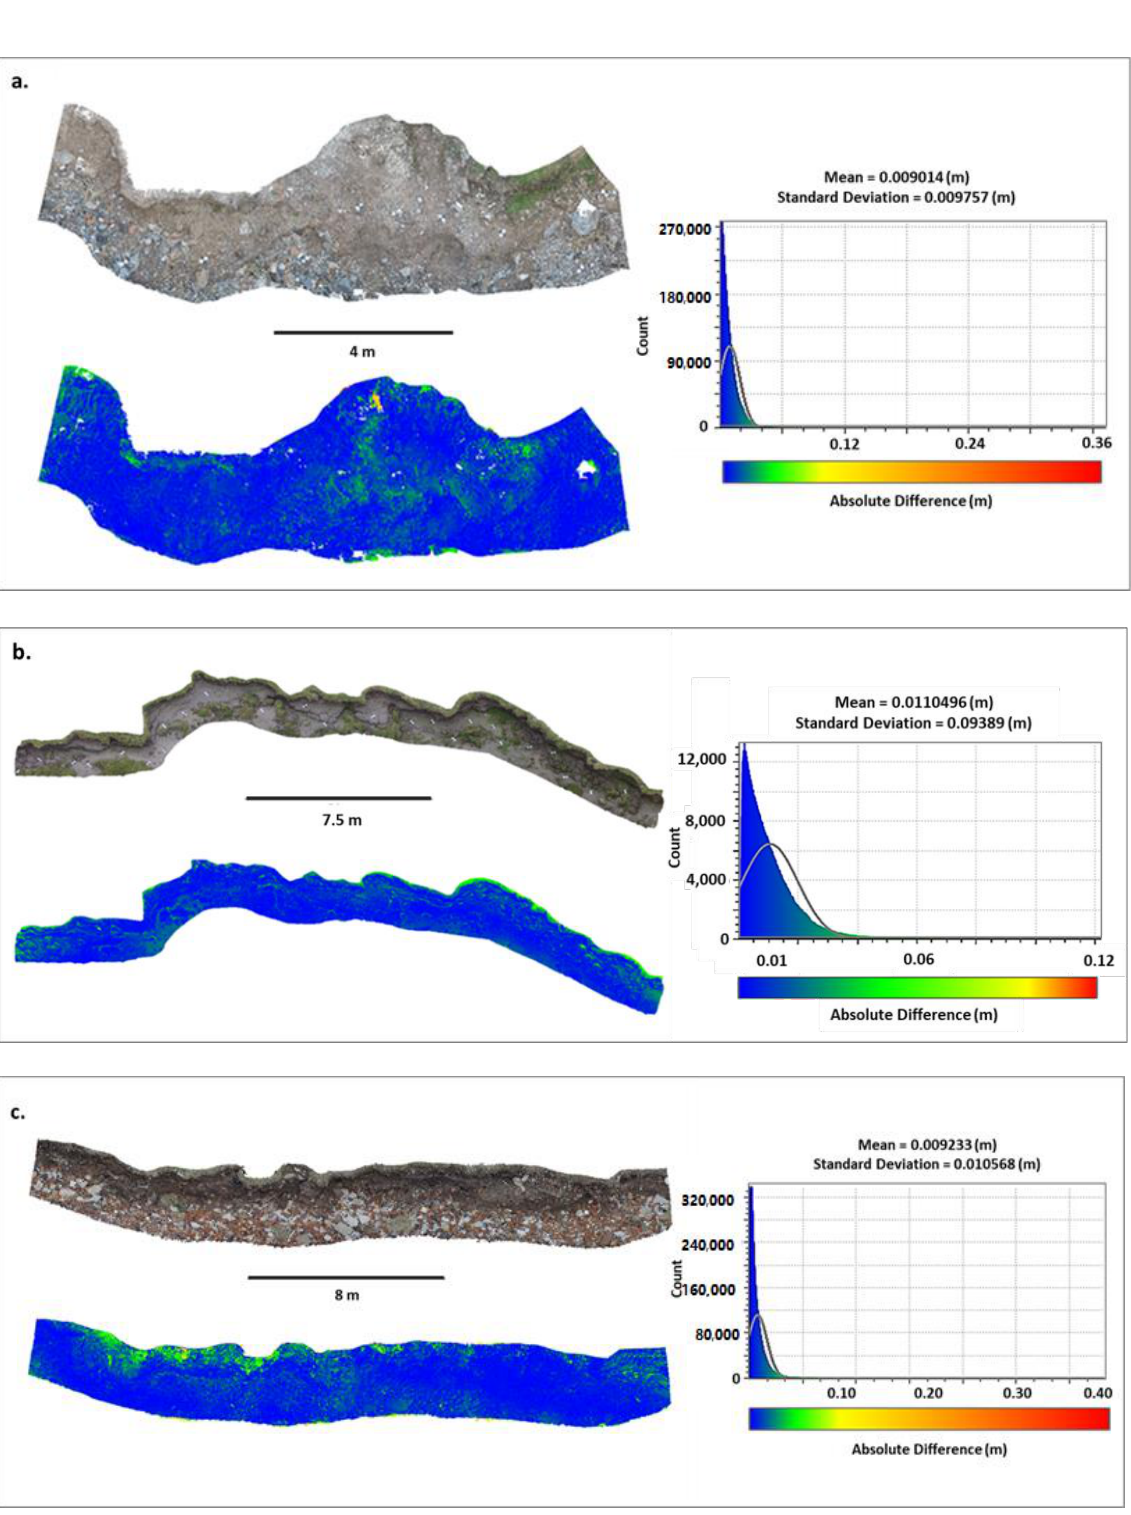
Figure 6. Scalar fields displaying the highest C2C values for each site: ( a ) Thurstaston, ‘Ultra-high’ densification (highest mean C2C value — 9.01 mm) dense point cloud. ( b ) Silverdale, ‘Low’ densification (highest mean C2C value — 10.4 mm) dense point cloud. ( c ) Crosby, ‘Ultra-high’ densification (highest mean C2C value 9.23 mm) dense point cloud.